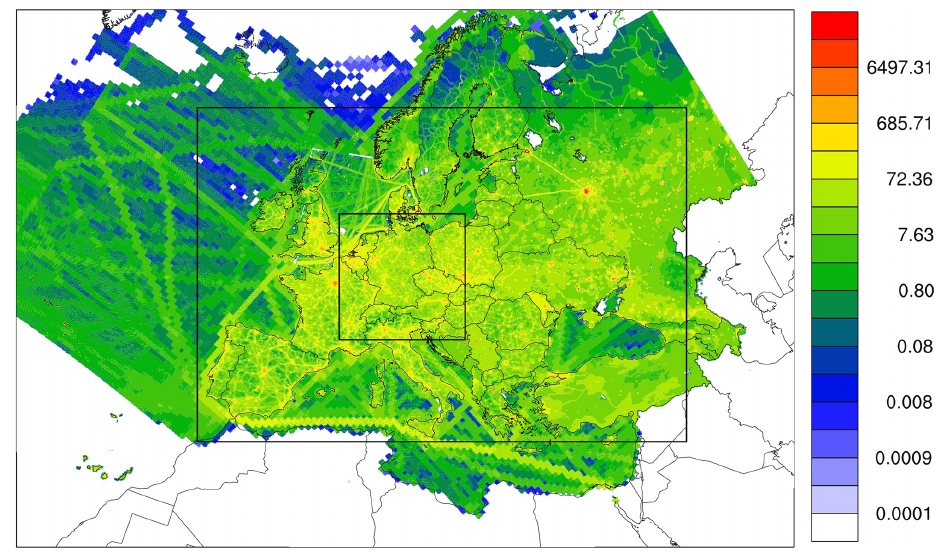
Figure 2. Emission rates of EC (kgm − 2 yr − 1 ) from EUCAARI (resolution 7km). The two nested model domains are indicated by black lines. Table 2. Overview of the model runs, regarding EC emission inventory and calculation of absorption (setting of the BC refractive index). Model BC emissions Absorption Emission totals run settings R1 EUCAARI EUCAARI scaled to